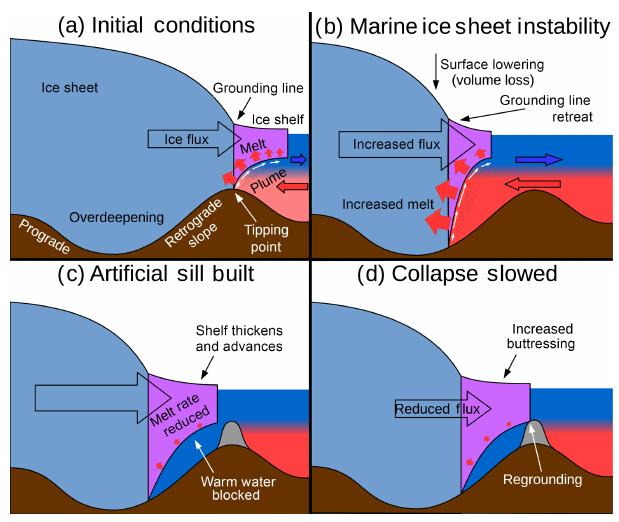
Figure 1. Schematic diagram of marine ice sheet instability and mitigation with an artificial sill. Brown represents bedrock, light blue represents the grounded ice sheet, purple represents the floating ice shelf, and gray represents an artificial sill. Ocean temperatures are drawn to represent the typical stratification faced by marine- terminating ice streams: warm salty water at depth and cold fresh water near the